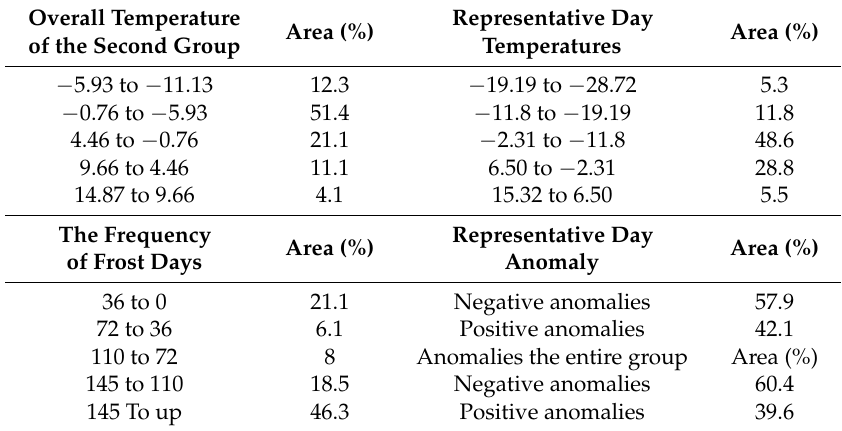
Table 3. Percentage of the covered area of different classes of average temperature, anomalies and frequency of frosts for the second group.